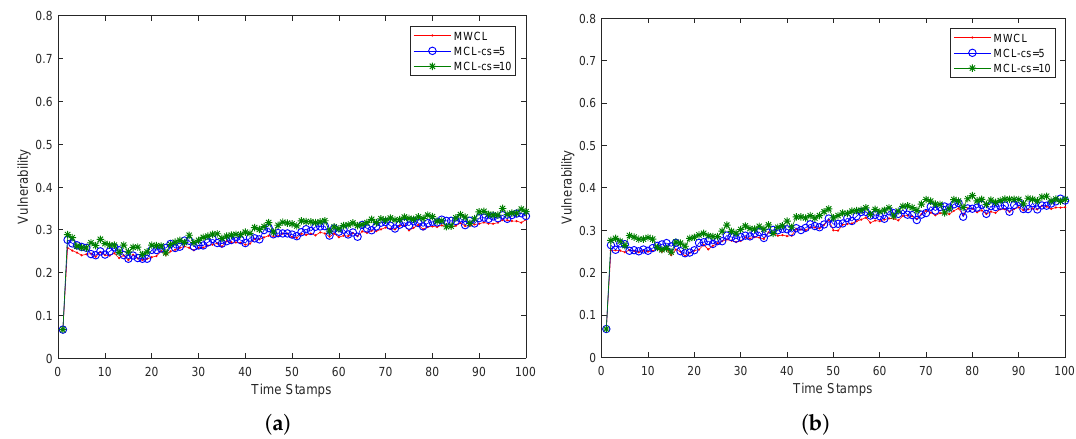
Figure 7. Both clustering and k -NN: ( a ) ( x , y , g ) and ( b ) ( x , y , g , v ) for N = 2000 trajectories and L = 100 time-stamps.